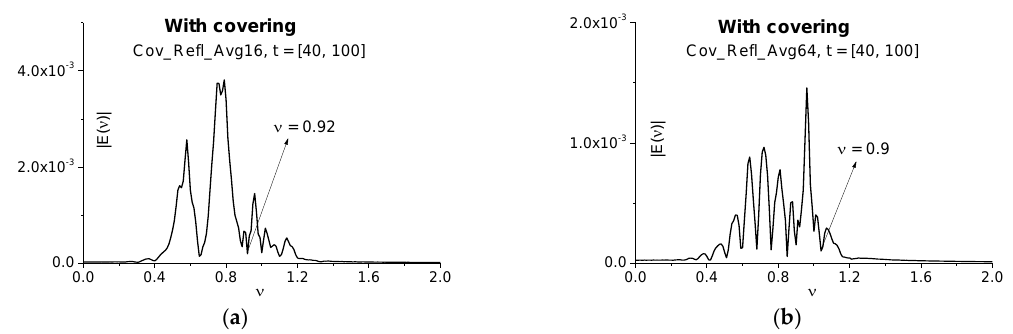
Figure 16. Fourier spectra of the signals Cov_Refl_Avg16 ( a ) and Cov_Refl_Avg64 ( b ) reflected from the covered medium in the time interval t = [40, 100] not containing the main pulse.